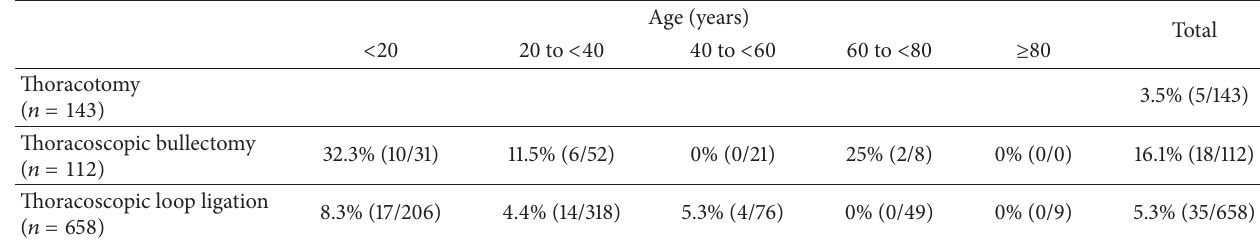
Table 3: Distribution of recurrence rates by